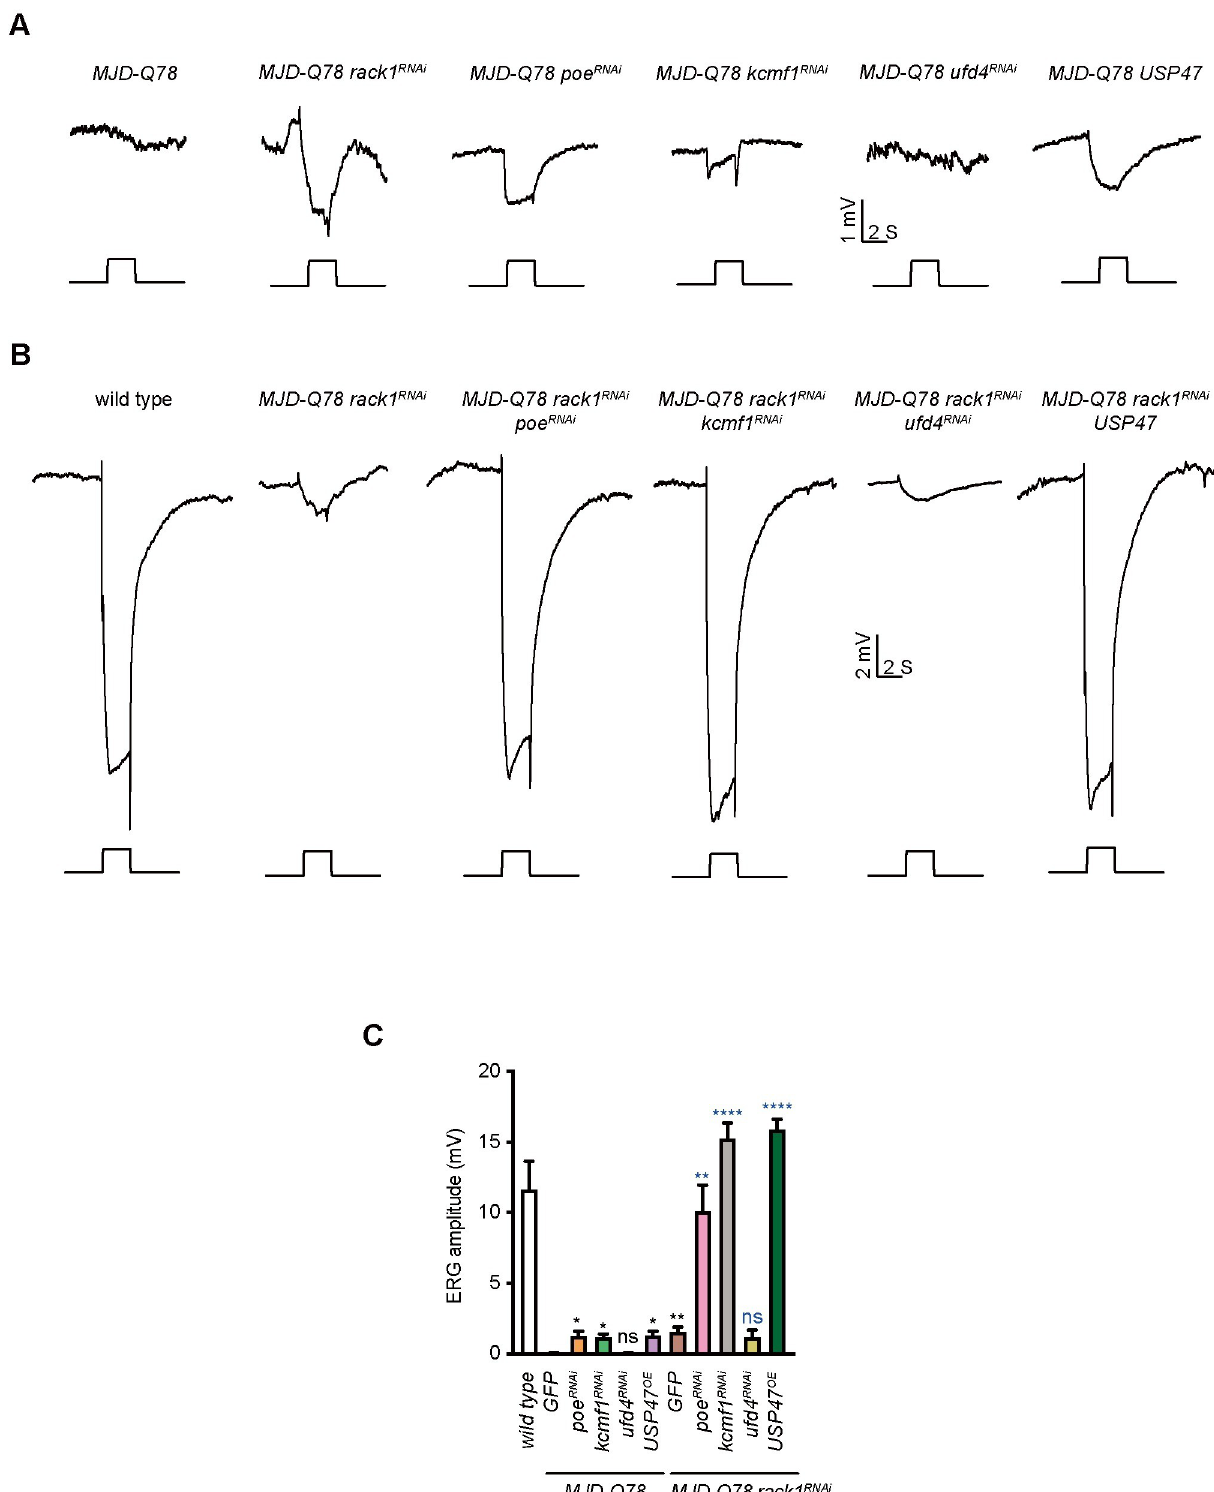
Fig 4. POE and KCMF1 enhanced rack1 RNAi restoration of photoreceptor functions in MJD model. (A) ERG recordings from 1-day-old MJD-Q78 ( GMR-GAL4/+;UAS-MJD . tr-Q78/+ ), MJD-Q78 rack1 RNAi ( GMR-GAL4 UAS-rack1 KK109073 ;UAS-MJD . tr-Q78/+ ), MJD-Q78 poe RNAi ( GMR-GAL4/+; UAS-MJD . tr-Q78/UAS-poe HMS00739 ), MJD-Q78 kcmf1 RNAi ( GMR-GAL4/+;UAS-MJD . tr-Q78/UAS-kcmf1 HMS00511 ), MJD-Q78 ufd4 RNAi ( GMR-GAL4/+;